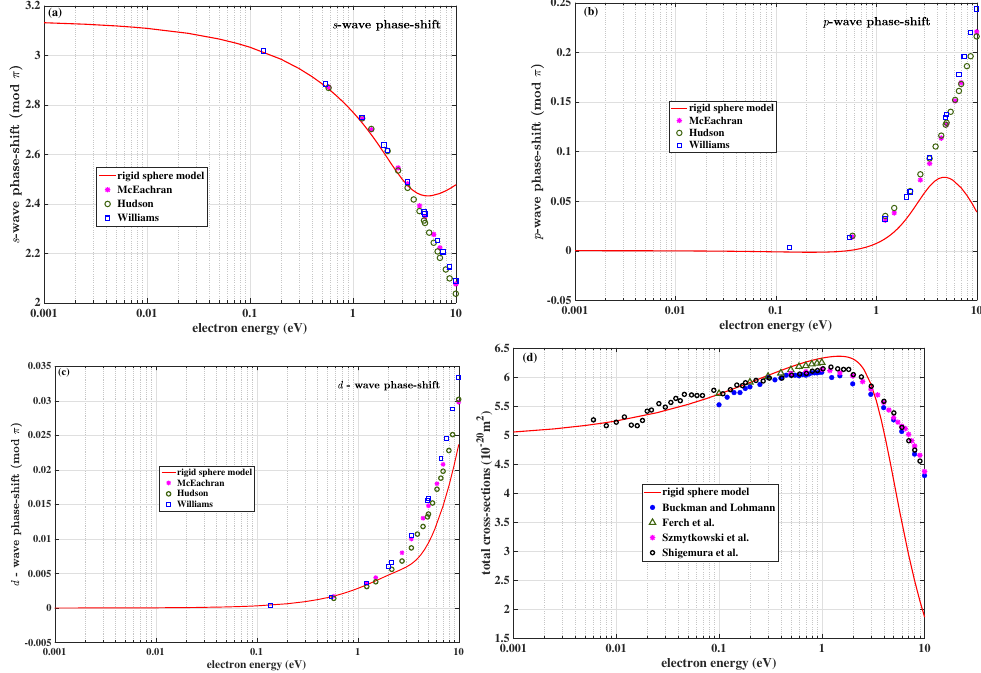
Figure 9. The rigid sphere model (solid lines) for low-energy e − − He scattering: ( a ) s − wave phase − shift, ( b ) p − wave phase − shift, ( c ) d − wave phase − shift, and ( d ) integral elastic cross − sections. The model is compared with other works: phase − shifts by McEachran and Stauf- fer [84], Hudson et al. [85], and Williams [86]; total cross − sections by Buckman and Lohmann [34], Ferch et al. [87], Szmytkowski et al. [35], and Shigemura et al.